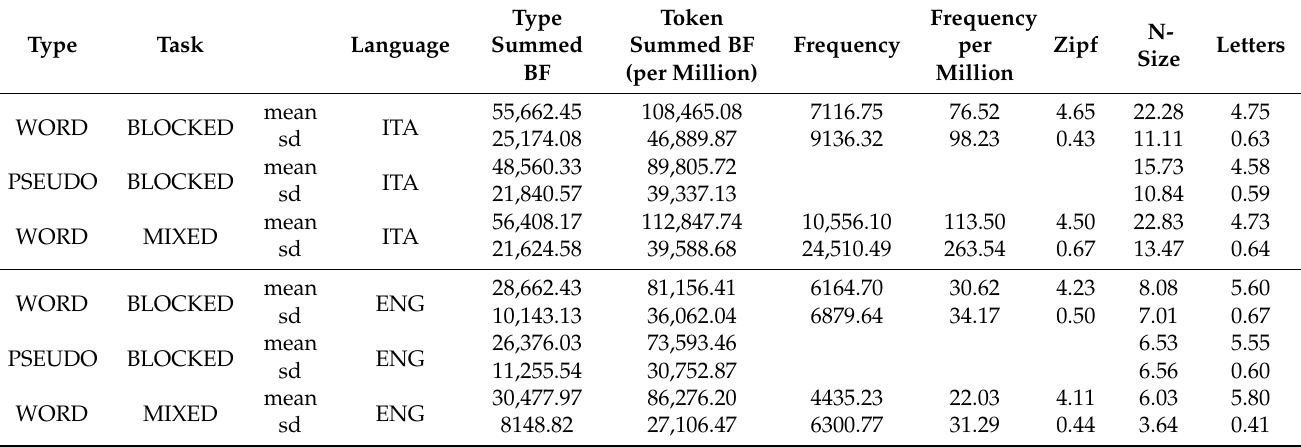
Table 2. Stimuli, frequency, bigram frequency and orthographic neighborhood size. Mean frequency for words and bigram frequency as well as orthographic neighborhood size (N-size) for words and pseudo-words in the two languages according to the SUBTLEX-UK [36] and the SUBTLEX-IT